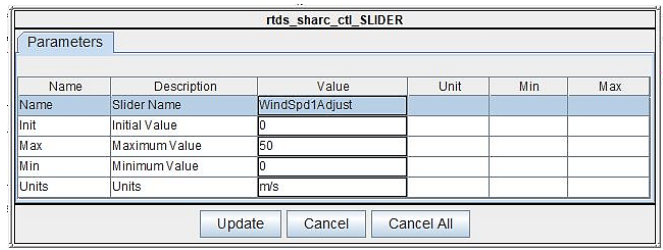
Figure 11. Wind speed adjustment settings.